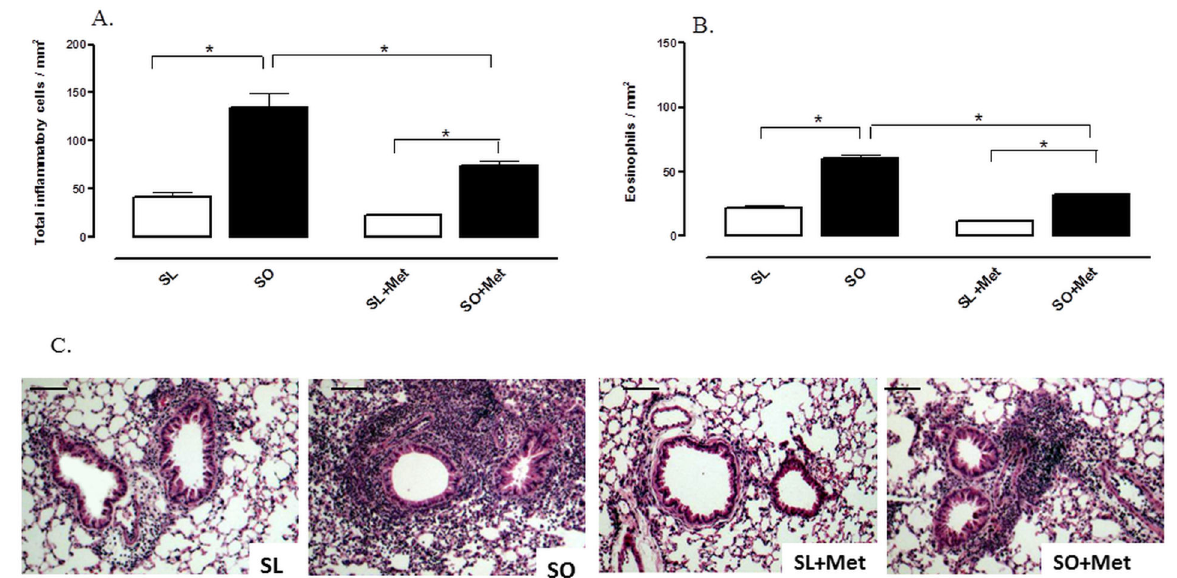
Figure 5. Effect of metformin treatment (300 mg/kg/day, two weeks) on the number of total inflammatory cells (A) and eosinophils (B) in lung connective tissue surrounding the bronchial and bronchiolar segments at 48 h following intranasal challenge with ovalbumin in the sensitized mice. Representative high-power fields of bronchiolar structures from the following groups: mice sensitized lean treated with vehicle (SL), sensitized obese treated with vehicle (SO), sensitized lean treated with metformin (SL + Met) and sensitized obese treated with metformin (SO + Met). Panel C shows representative images of lung histology for the four experimental groups. Haematoxylin–eosin, high magnification (bar represents 20 µm). Each column represents mean ± SEM (n = 6) of the number of cells mm 2 . *p<0.05. doi: